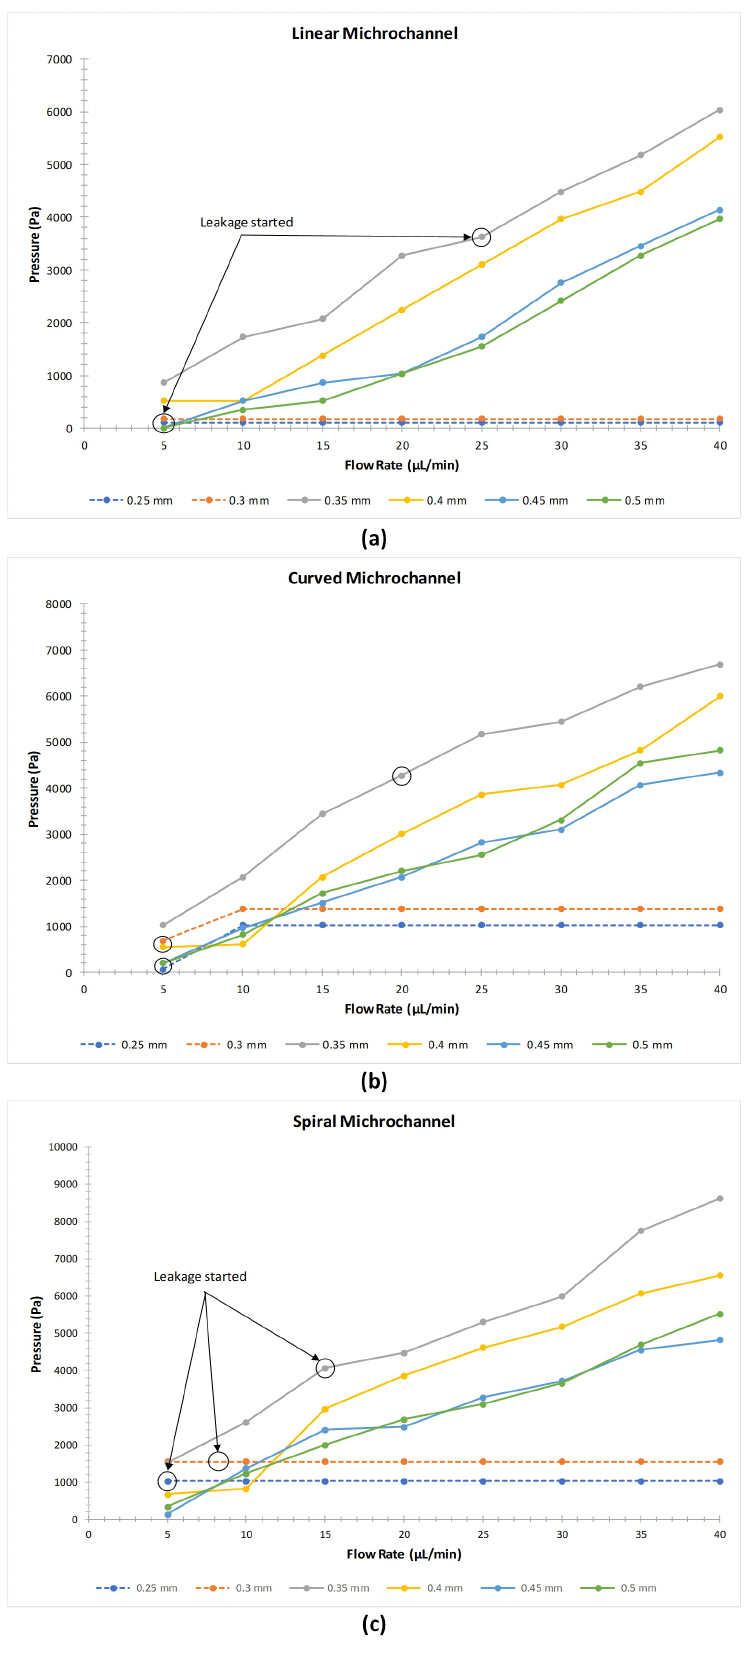
Figure 8. Change in flow rate vs developed pressure at the inlet port of ( a ) linear microchannel, ( b ) curved microchannel and ( c ) spiral